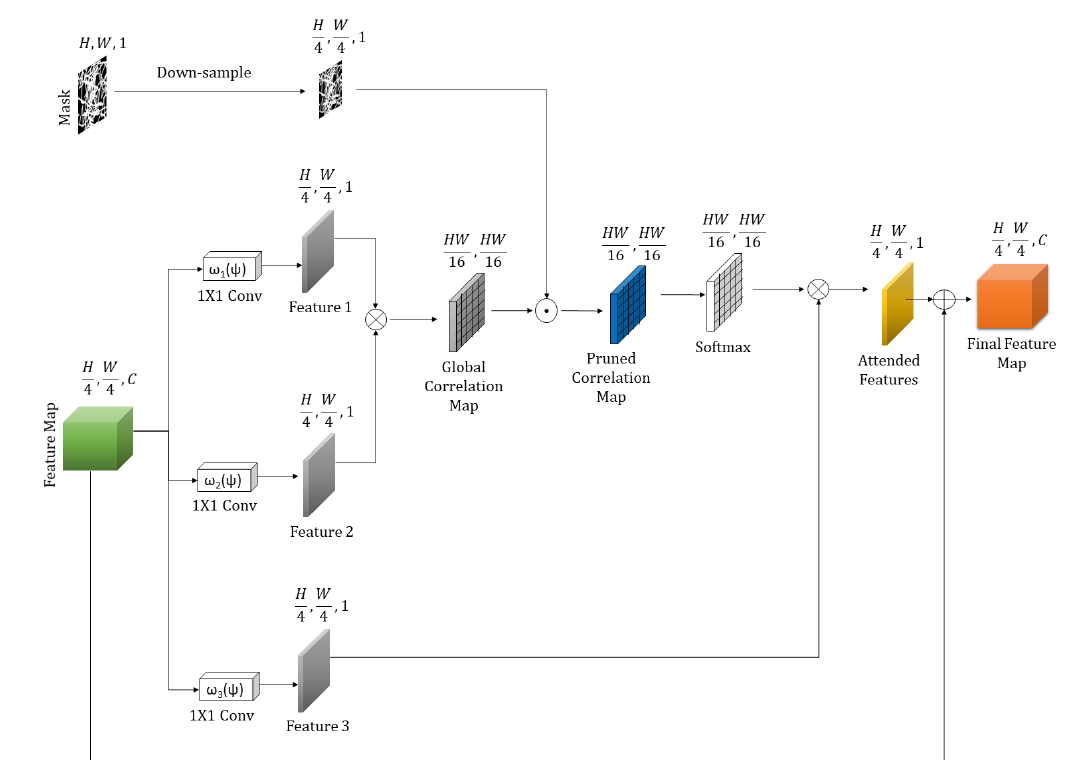
Figure 3. Overview of mask pruning-based global attention module. The module takes feature maps and a binary mask as input. The module calculates the global correlation among features and prunes the mask values from the correlation map. It then chooses the most contributing features from the pruned features and reconstructs the final feature